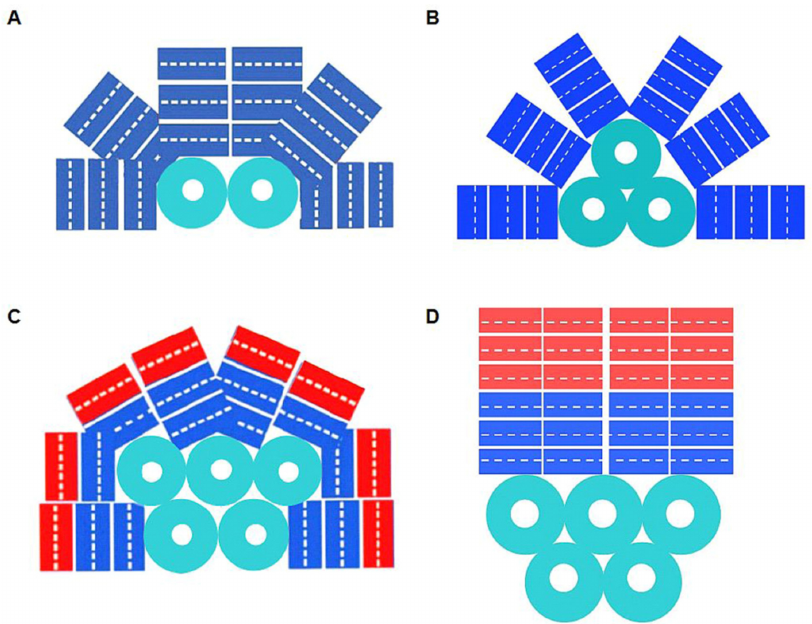
Figure 2. Morphological types of cyanobacterial PBSs. ( A ) Hemidiscoidal PBS with the bicylindrical core. ( B ) The most typical hemidiscoidal PBS with the tricylindrical core and six lateral cylinders. ( C ) PBS with the pentacylindrical core and eight lateral cylinders. ( D ) Bundle-shaped PBS ( Gloeobacter type). APC —light blue; PC —blue; PE —red color. In the PBS, absorbed solar energy is funneled from the lateral cylinders to the core and eventually to the terminal longwavelength emitters—chromophorylated ApcD and Apc F varieties of APC subunits and the ApcE (Lcm) andchromophorylated large core-membrane linker proteins located in the bottom of APC cylinders. From collectively acted terminal emitters, the energy rapidly rolls to PS I and PS II [19–21]. Regarding PS II, there has long been a general consensus that in the plane of the thylakoid membrane, PBSs are disposed on the outer surface of PS II dimers [22]. The situation with PS I is more complicated [23–26]. In cyanobacteria, PS I mainly forms trimers with a certain share of monomers [27,28]. In contrast to the PS II dimers [22], the surface of PS I shows a major protrusion of three hydrophilic polypeptide sub- units (PsaC, PsaD, and PsaE), which extends into the cytoplasm [27,28] and prevents a tight binding of PBS to PS I trimer due to its threefold symmetry. Computer modeling demonstrated the docking of PBS to the PS I monomer only, corresponding to a realiza- tion of a highly likely energy transfer between these two pigment–protein complexes [29]. Along with the “common” PBSs and the “common” cyanobacteria, there are other species that have caught everyone’s attention. 2.1. Prochlorophyta: Chlorophyll b-Containing Cyanobacteria Prochlorophyta, or Prochlorales, is a mixed group of cyanobacteria containing Chl a/b -proteins instead of PBS as a photosynthetic antenna. Few known Prochlorophyta members form three genera, namely, Prochlorococcus, Prochloron , and Prochlorothrix , with cells having green or greenish color. The genus Prochlorothrix is represented by two fila- mentous freshwater species, P. hollandica [30] and P. scandica [31]. P. didemni , the only one known species of the Prochloron genus, is an obligate symbiont of the didemnid ascidia Lissoclinum patella [32]. Various described ecotypes of the genus Prochlorococcus marinus inhabit different geographical areas of the ocean and belong to the most abundant rep- resentatives of oceanic photosynthetic picoplankton.